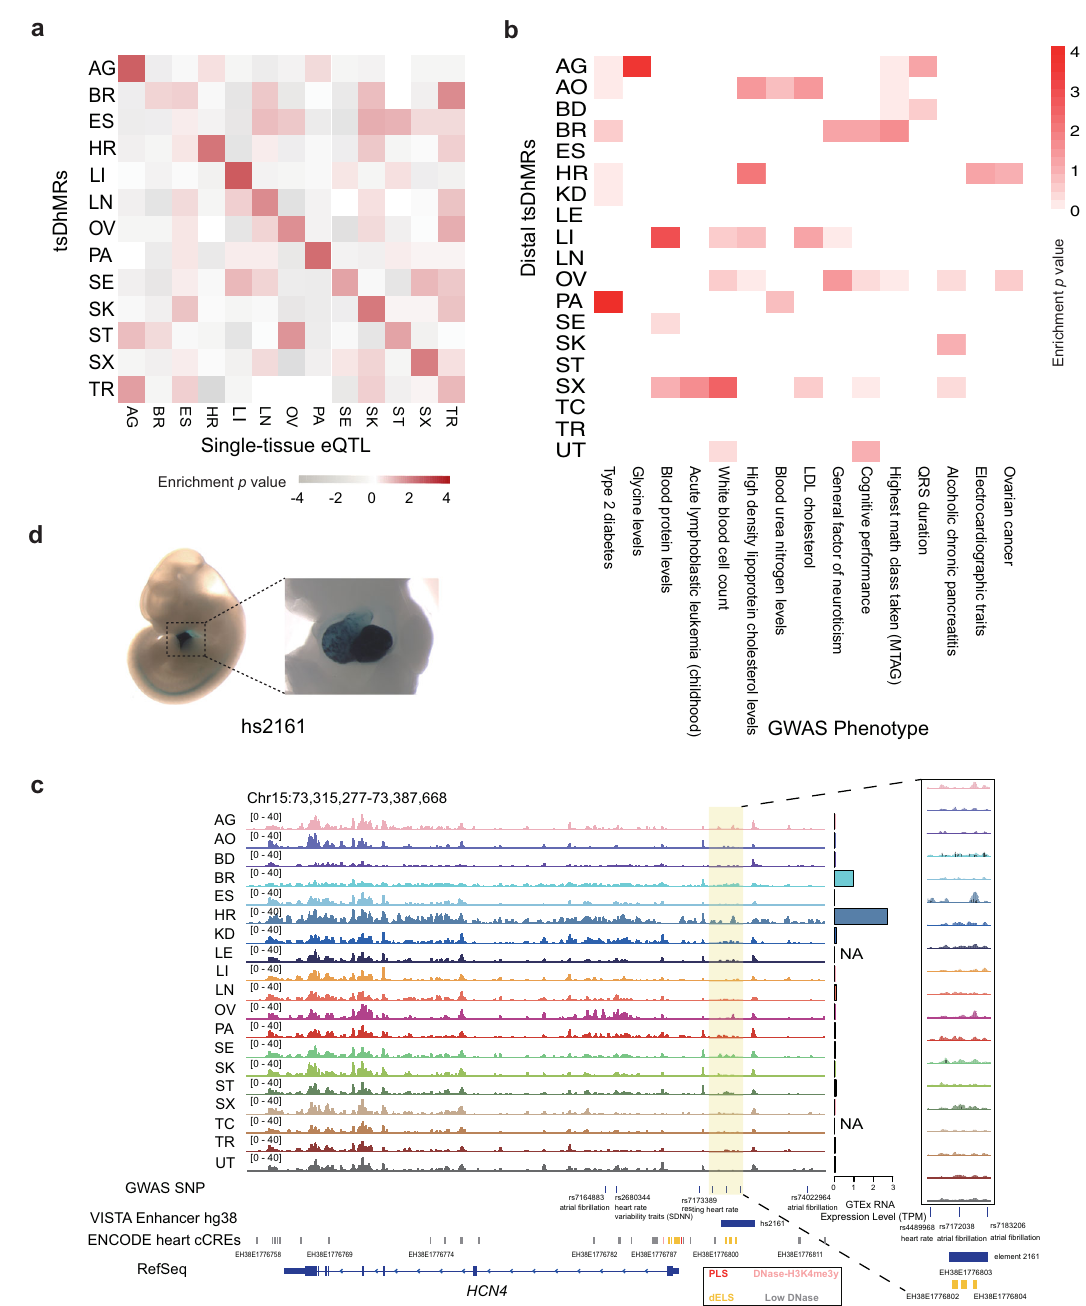
Fig. 6 tsDhMRs enrich tissue-speci fi c, phenotypic GWAS SNPs. a Overlap of tsDhMRs with single-tissue eQTL SNPs. eQTL SNP data are from GTEx. One-sided (greater) fi sher ’ s exact test. b Representative GWAS phenotypes enriched in distal tsDhMRs. One-sided (greater) fi sher ’ s exact test. c IGV visualization of the 5hmC signals around HCN4 on chromosome 15. The locations of GWAS SNPs and VISTA enhancers are also shown. The highlighted region shows the LI-speci fi c DhMRs. d In vivo reporter assay of enhancer activity for hs2162. This pictures were obtained from the VISTA enhancer browser 35